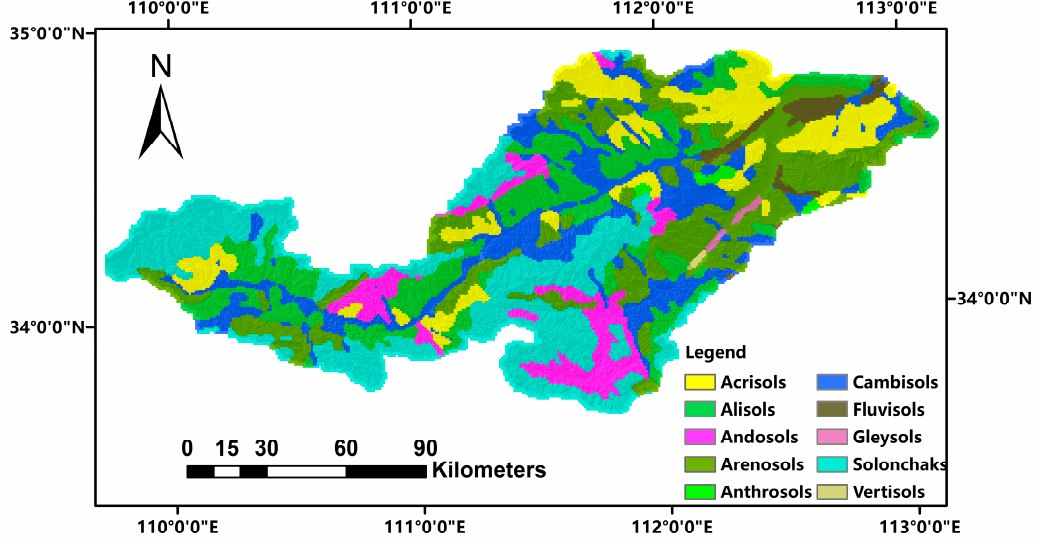
Figure 2. Soil types within the study area.